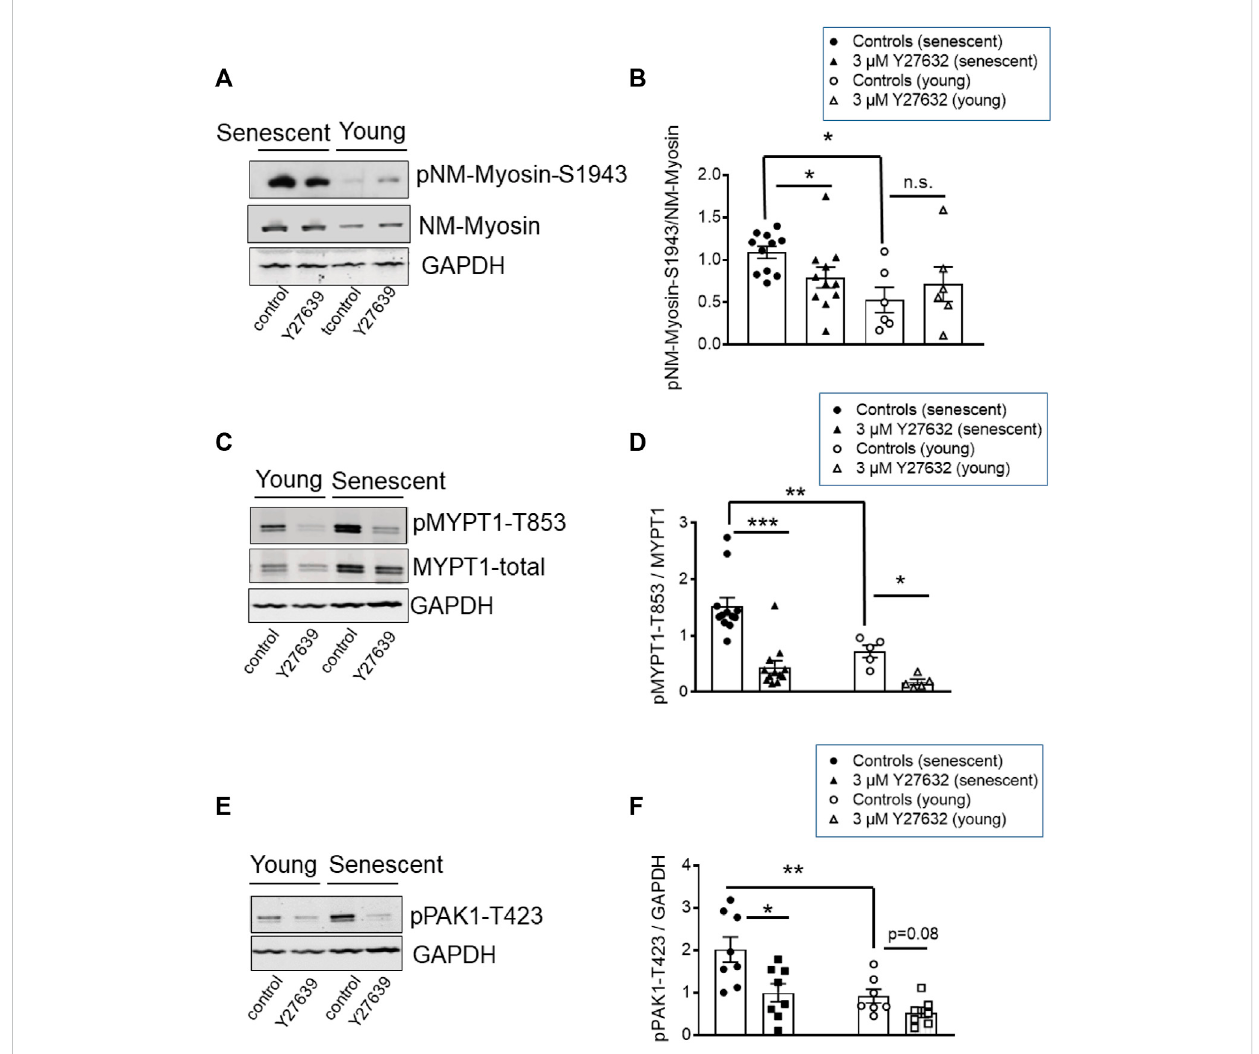
FIGURE 8 PhosphorylationofNM-II-S1943,MYPT1-T853,andPAK-T423inbasilararteriesfromyoung andsenescentmiceundercontrolconditionsandafter inhibition of ROK. (A – C) Original western blots and statistic evaluation of the phosphorylation of MYPT1 at T853 (A,B) , non-muscle-myosin II (NM- Myosin) at S1943 (C,D) and PAK-T423 (E,F) in y- and s-BAs from WT animals ( n = 10 – 6). Preparations were treated either by vehicle (0.5% H 2 O; controls) or by 3 μ mol/L Y27632, shock-frozen and subjected to Western blot as described in “ Methods. ” ** p < 0.01 and * p < 0.05; control y-BAs vs. control s-BAs; two-way ANOVA. ** p < 0.001 and * p < 0.05; unpaired t